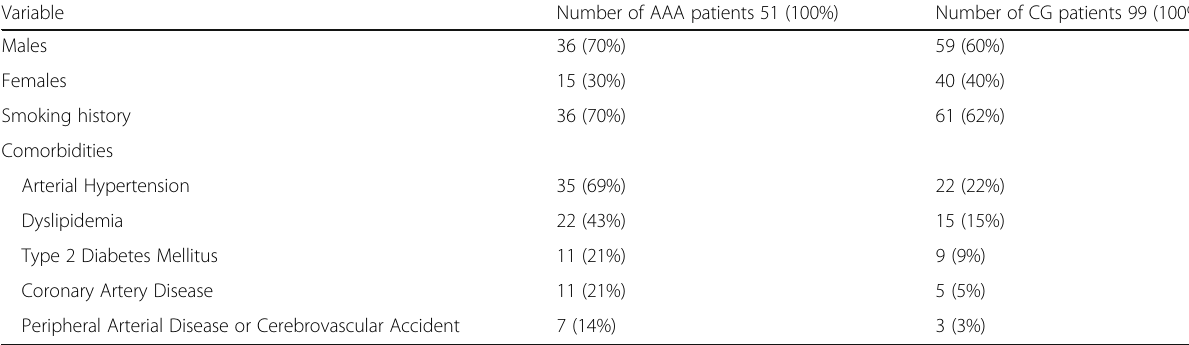
Table 1 Demographics and comorbidities of Abdominal Aortic Aneurysms and control group (CG) patients Variable Males